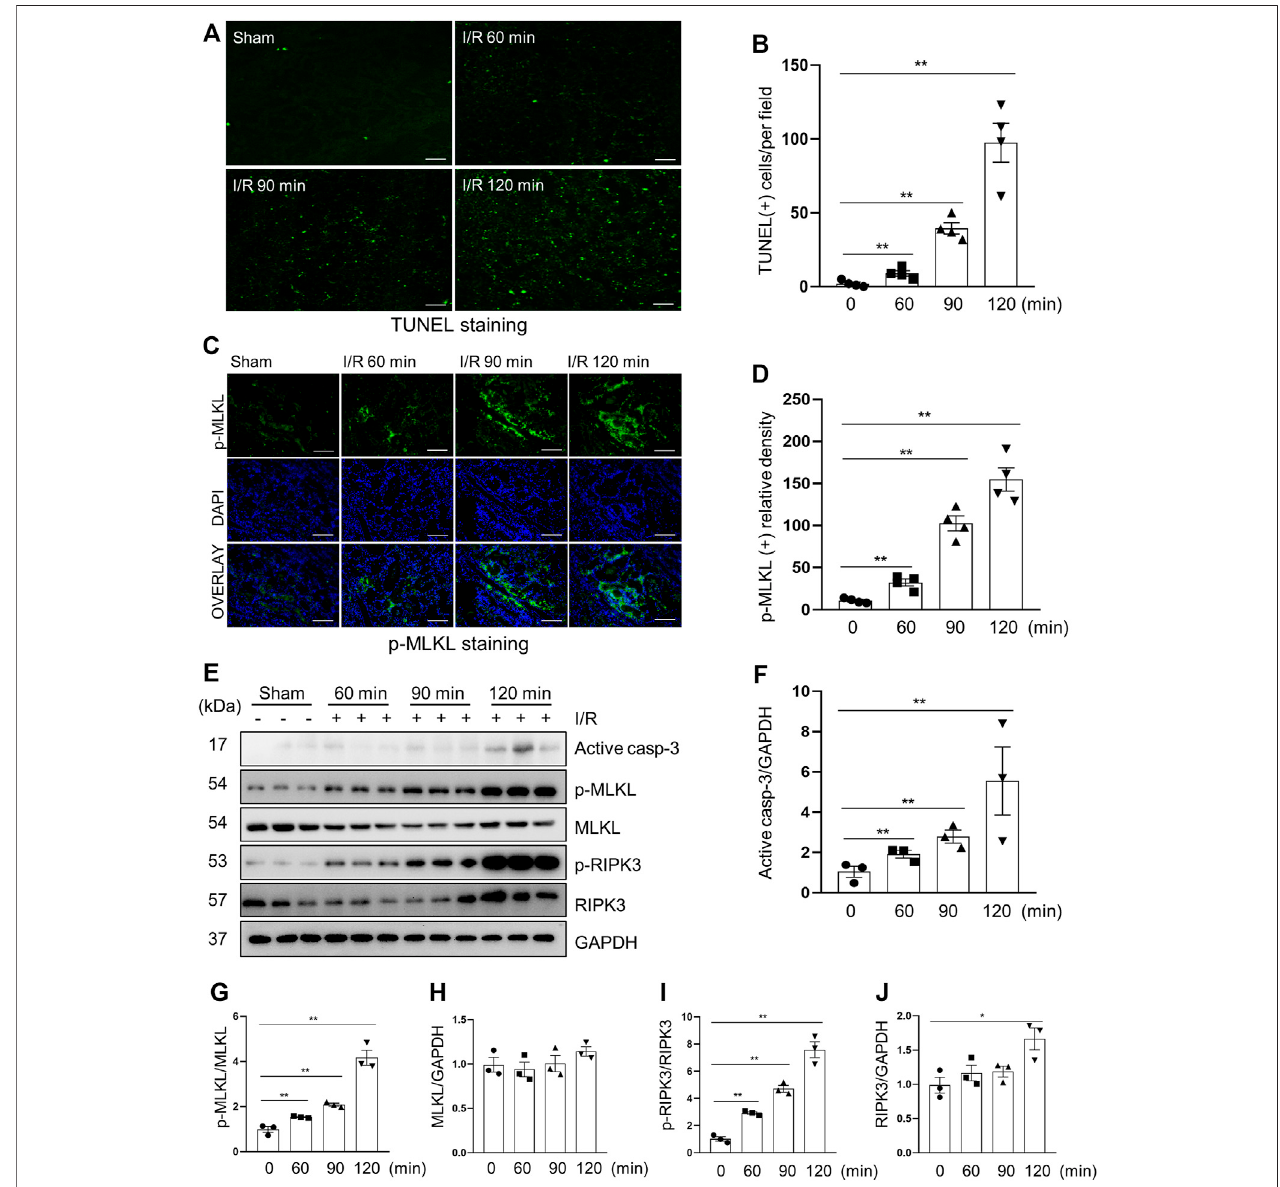
FIGURE 2 | Apoptosis and necroptosis levels in miniature pigs with acute kidney injury induced by ischemia-reperfusion. (A) Representative images of TUNEL staining of kidney tissue from each group. Scale bar = 100 µm. (B) Quanti fi cation and plot of the TUNEL stained images. (C) Photomicrographs illustrating immuno fl uorescence staining of phospho-MLKL. Scale bar = 200 µm. (D) Quanti fi cation and plot of the immuno fl uorescence integrated density of phospho-MLKL. (E) Porcinekidneytissuelysatesfromfourgroupsweresubjecttoimmunoblotanalysiswithspeci fi cantibodiesagainstcleaved-caspase3,MLKL,phospho-MLKL, RIPK3 and phospho-RIPK3. Expression levels of cleaved-caspase 3 (F) , MLKL (H) and RIPK3 (J) were quanti fi ed by densitometry analysis and then normalized with GAPDH.ThephosphorylationlevelsofMLKL (G) andRIPK3 (I) werecalculatedquantitativelybydensitometry. Dataaremeans±sem.* p < 0.05;** p < 0.01versussham